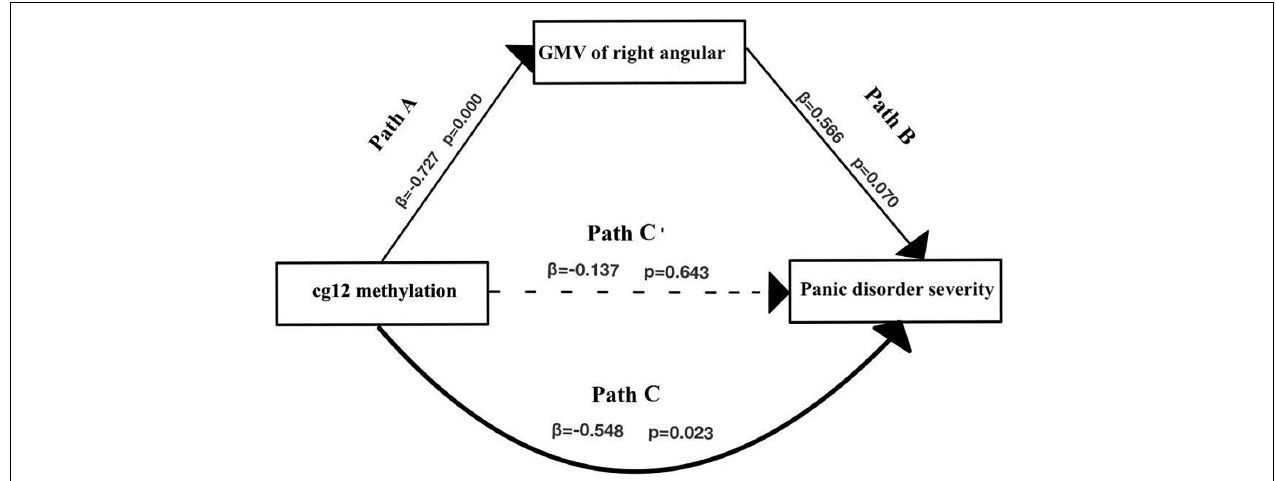
FIGURE 6 | Mediation effect model with three variables. Mediation analysis suggested that cg12/171674146 CpG methylation mediated the relationship between GMV in the right ANG and PD severity. Indirect effect of cg171674146 on PDSSSUM = 95% CI: –0.983 to –0.114. Direct effect of cg171674146 on PDSSSUM (Path C (cid:48) ) = 95% CI: –0.652 to 0.626. Total effect of cg171674146 on PDSSSUM (Path C) = 95% CI: –0.813 to –0.157.